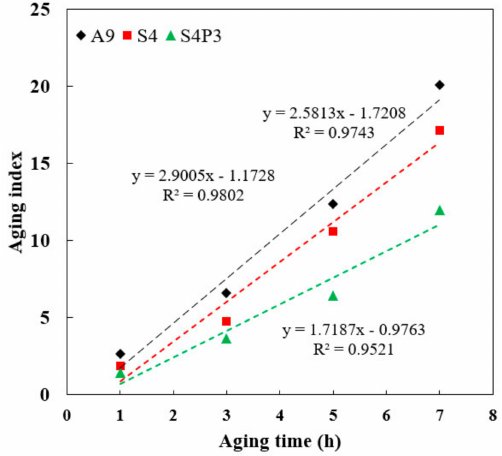
Figure 3. Correlation diagram of aging time with